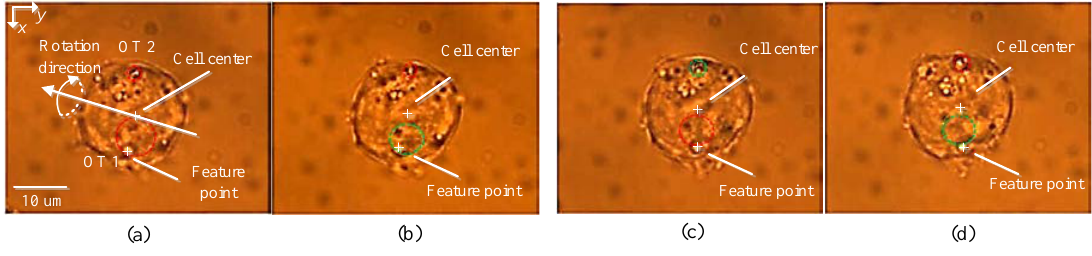
Figure 2. Snapshots of moving two groups of microparticles into arrays with an artificial potential field-based controller. ( a ) 0 s; ( b ) 1 s; ( c ) 3.5 s; ( d ) 4.5 s. Reproduced with permission from [20].